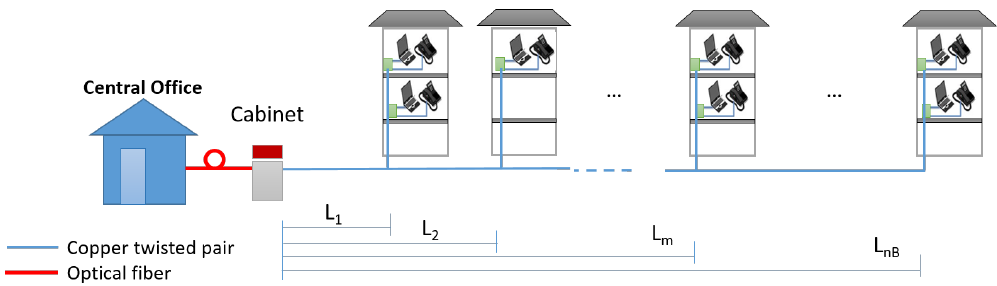
Figure 1. Considered fiber-to-the-cabinet (FttC) generic interference